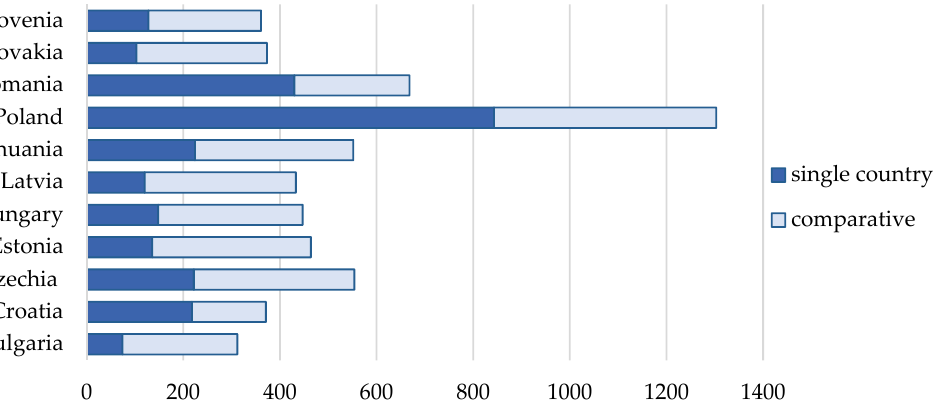
Figure 8. Share of single country and comparative studies among the 11 CEE countries. Source: Authors; N = 5838.